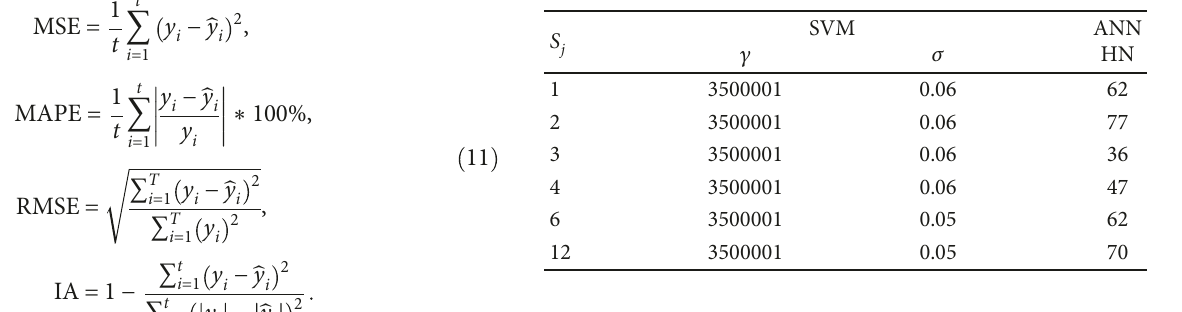
Table 2: Parameters for